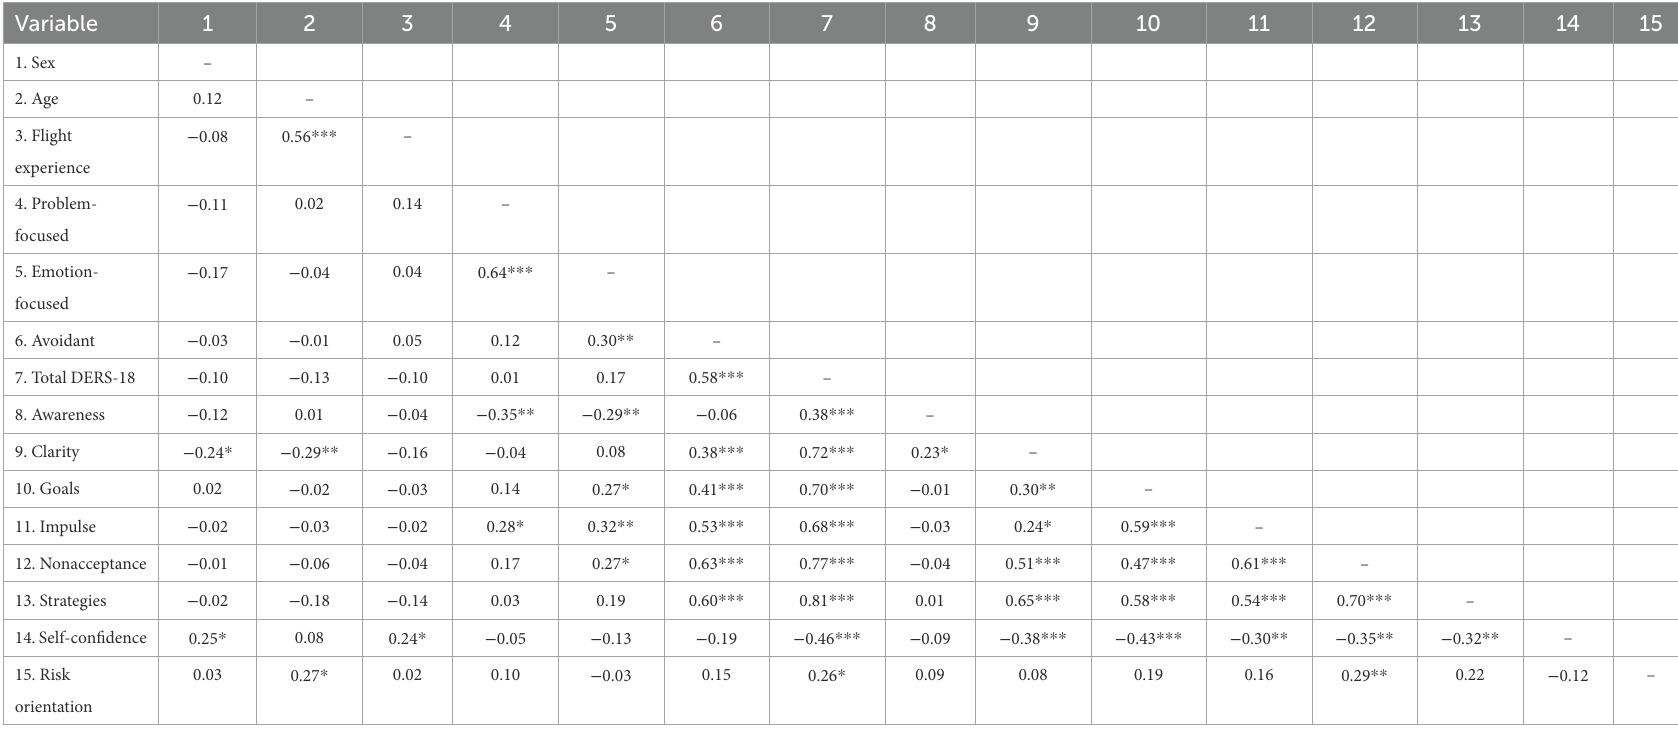
TABLE 2 Pearson’s correlations performed between sex, age, flight experience coping style (problem-focused, emotion-focused, avoidant), emotional dysregulation (Total DERS-18, awareness, clarity, goals, impulse, nonacceptance, strategies) and risk attitudes (self-confidence and risk orientation).